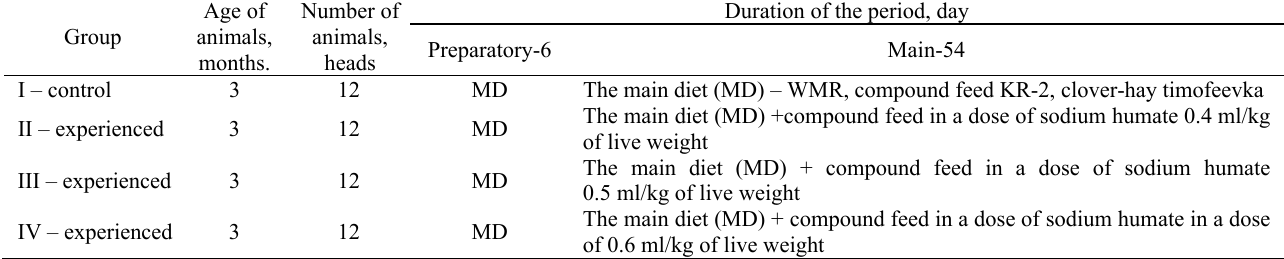
Scheme of experience